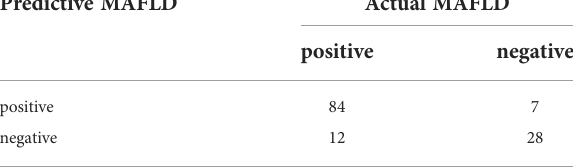
MAFLD, metabolic associated fatty liver disease. Accuracy=85.5%,sensitivity=87.5%,speci fi city=80%,positivelikelihoodratio=4.375, negative likelihood ratios =